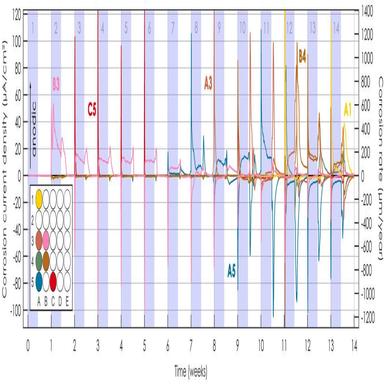
Anodic and cathodic currents for the CEM II specimen over 14 weeks of exposure to cyclic wetting and drying. Only electrodes that had significant corrosion activity are displayed.